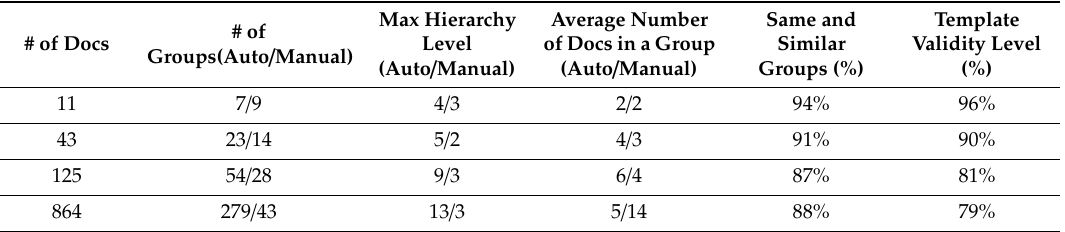
Table 1. Validation of clustering results: Experts vs. system